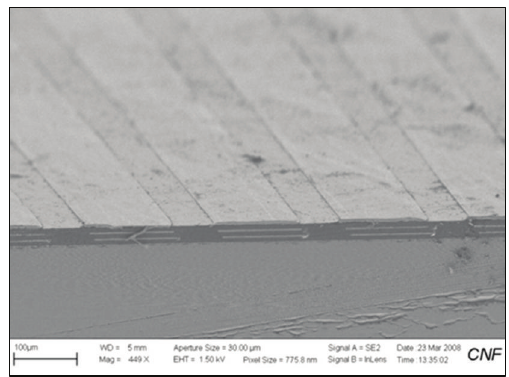
Figure 7: SEM cross-sectional image of triple-layer inductor.